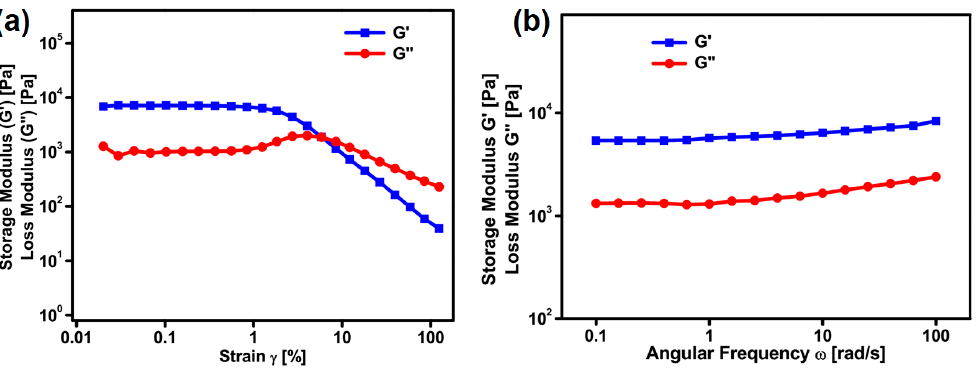
Figure 6. ( a ) Strain amplitude and ( b ) angular frequency dependence of G’ and G” of the hydrogel prepared from compound 5b .